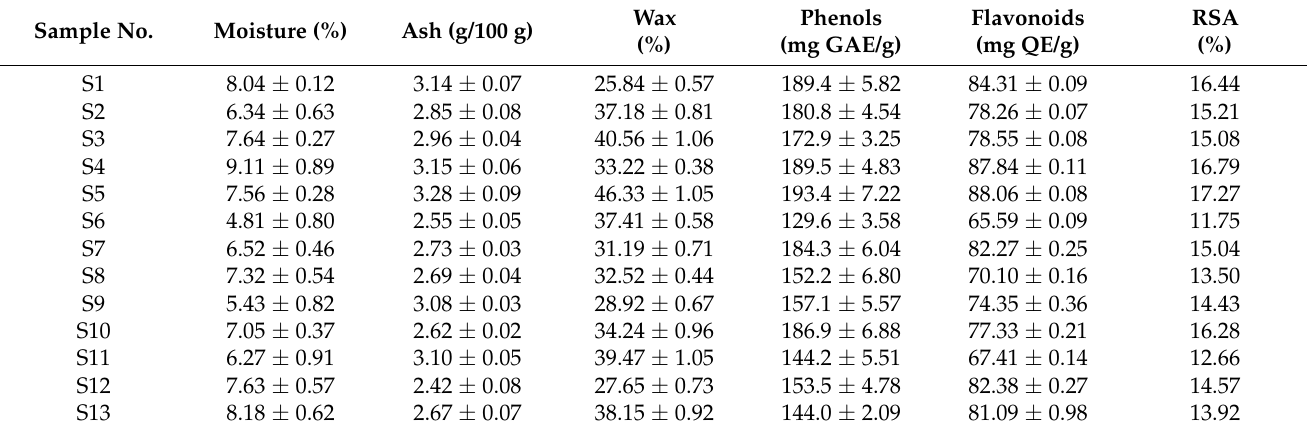
Table 5. Characterization of propolis samples from North-West and Central of Romania.